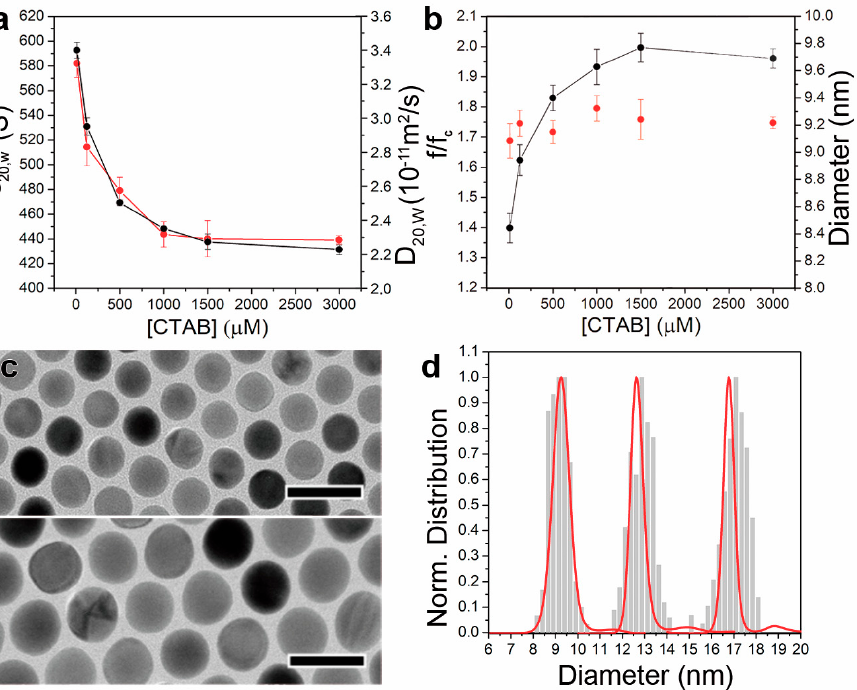
Figure 3. AUC determination of colloidal AuNC size distributions. ( a ) Variation of the s 20,w,AuNC@CTAB@W (black) and D 20,W,AuNC@CTAB@W (red, diffusion coefficient at standard conditions) of 9 nm AuNC as a function of the CTAB concentration. ( b ) Plot of the calculated (f/f c ) AuNC@CTAB@W (black) and dimension (red) of the 9 nm AuNCs at the different CTAB concentrations. ( c ). TEM images of AuNCs of 13 (top) and 17 nm (bottom) used in the AUC experiments. Scale bars: 25 nm. ( d ) Normalized size distributions of the 9, 13, and 17 nm AuNCs obtained from the analysis of TEM images (bars) and AUC data (red). A sharp decrease of the sedimentation coefficient (given at standard conditions, concentration from 10 to 125 and 500 µ M, respectively (Figure 3a). Between 500 µ M